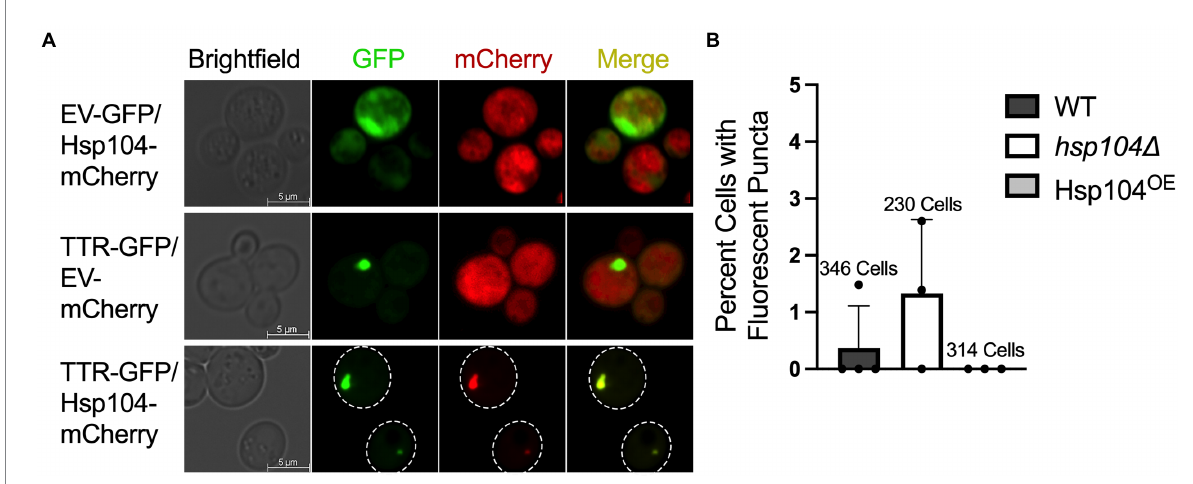
FIGURE 1 TTR-GFP forms fluorescent puncta that co-localizes with Hsp104. (A) hsp104 ∆ cells were transformed with the indicated plasmid combinations and grown for approximately 48 h. Representative fluorescent microscopy images with the indicated proteins are shown. (B) Cells in wildtype strains (WT; containing a genomic copy of HSP104 ), hsp104 ∆ strains, and hsp104 ∆ strains with a plasmid moderately overexpressing Hsp104 (Hsp104 OE ) were grown to log (OD 600 = 0.4–0.8, approximately 24 h). The percentage of GFP expressing cells containing puncta was plotted from 3 independent experiments. Total number of cells counted of the three experiments is reported above. Data is shown as means and standard